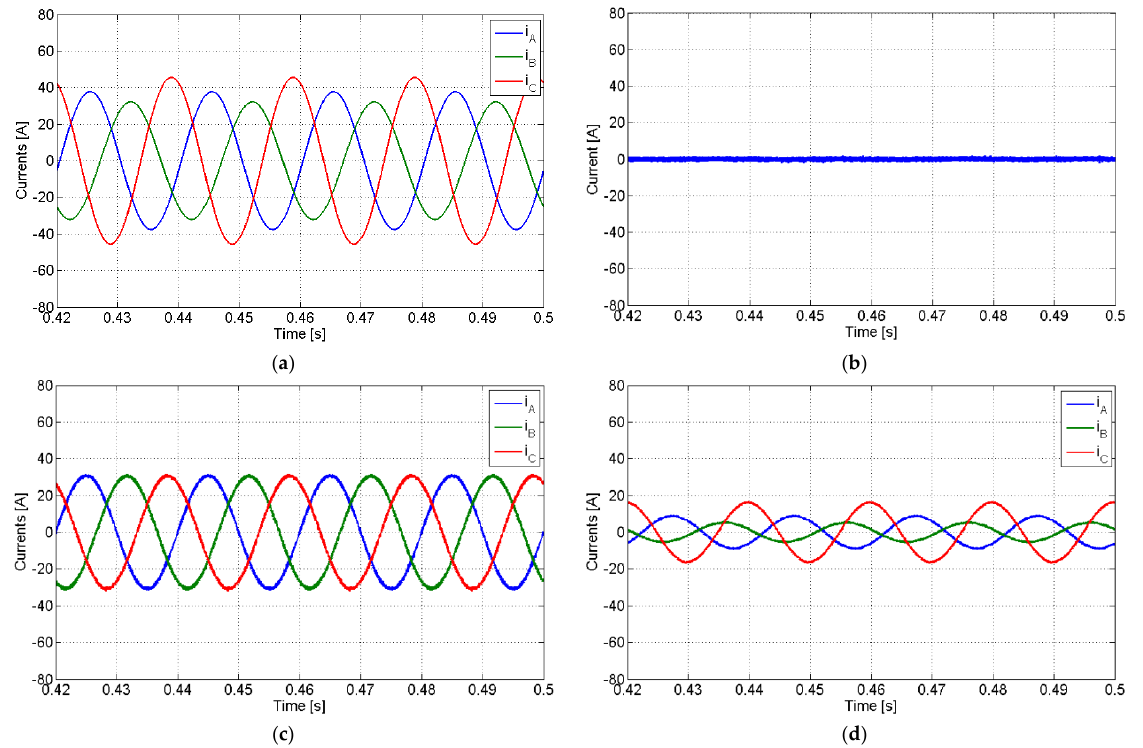
Figure 9. Simulation results with the PV generator operating in balanced mode with a linear load: ( a ) load currents; ( b ) current in the line between the fourth leg of the inverters; ( c ) AC currents of the PV generator; ( d ) grid currents.